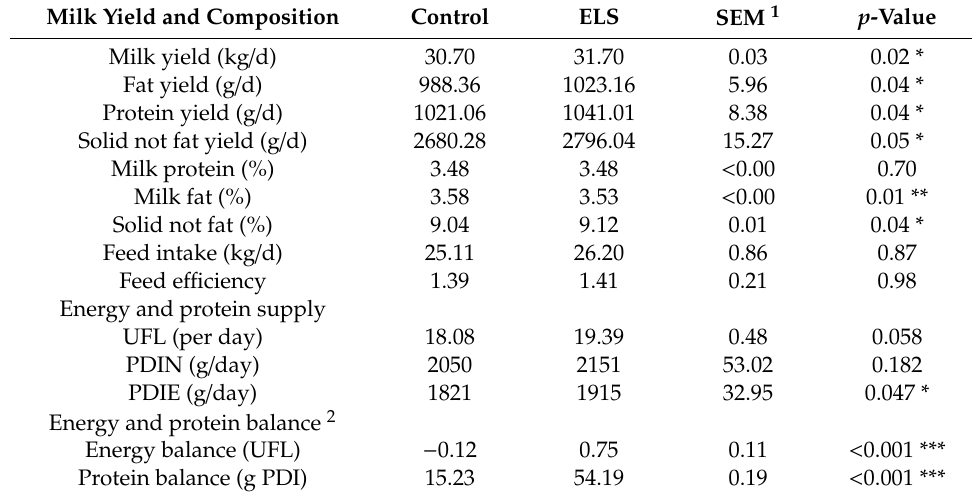
Table 4. Mean feed e ffi ciency, milk yield, and milk composition following the supplementation of Holstein dairy cow diets with extruded linseed and soybean (ELS) (n = 38) versus a control (n = 39). Milk Yield and Composition Control ELS SEM 1 p -Value Milk yield (kg / d) 30.70